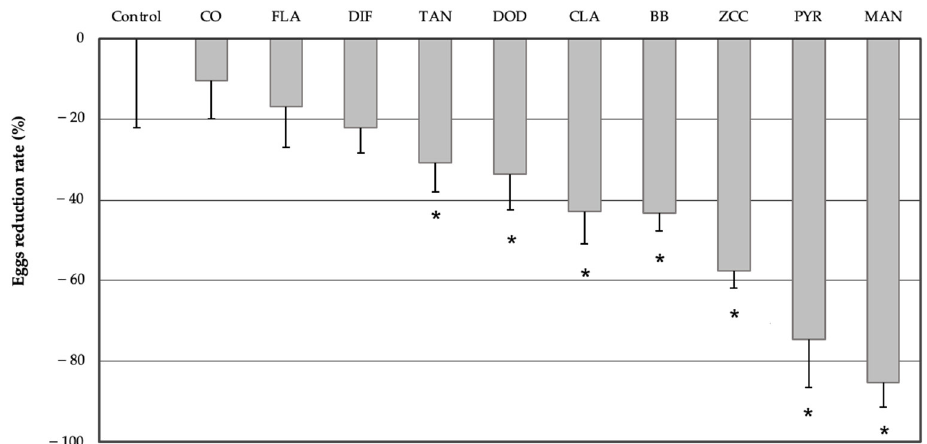
Figure 1. Eggs reduction rate (%) in treated olives compared to the control (set as zero). CO: copper oxychloride, FLA: flavonoids, DIF: difeconazole, TAN: tannins, DOD: dodine, CLA: clay, BB: B. bassiana , ZCC: zinc-copper-citric acid biocomplex, PYR: pyraclostrobin, MAN: mancozeb, compared to the control. * p < 0.05, significant differences compared to the control (negative binomial model). Bars indicate the negative standard error.